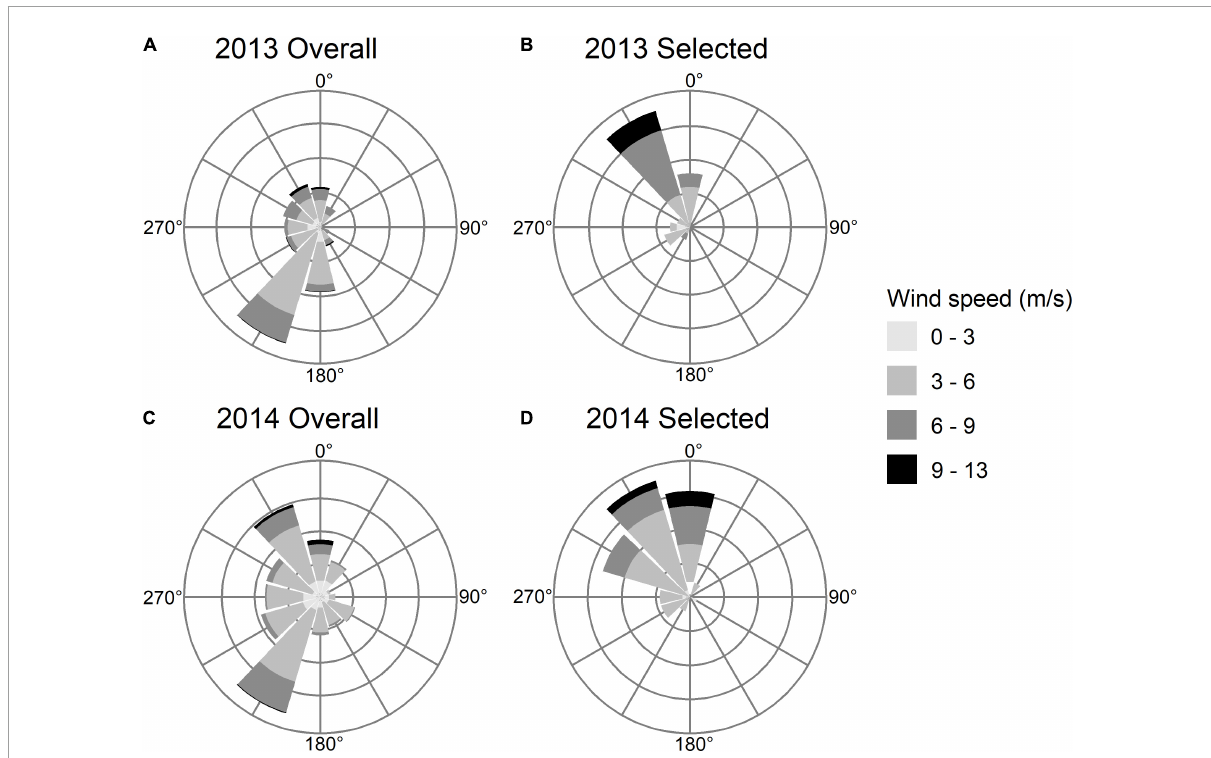
FIGURE7 Distribution of wind speed and direction throughout the Semipalmated Sandpiper departure period (August 22 to September 19) from the Bay of Fundy [ (A) 2013 Overall and (C) 2014 Overall] and during hours when birds departed [ (B) 2013 Selected and (D) 2014 Selected]. Size of the wedge indicates overall frequency of winds and number of birds departing during particular wind conditions in the “Overall” and “Selected” graphs,